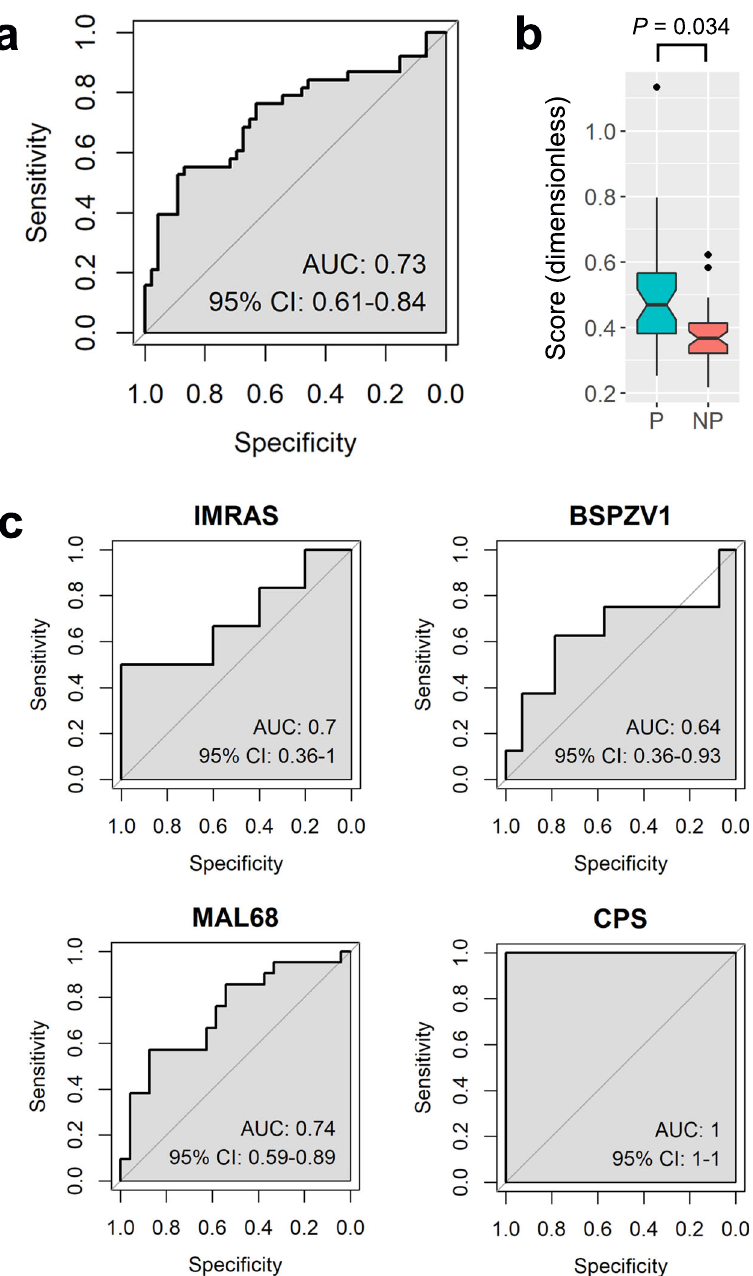
Fig. 5 Discriminatory power of the best-performing preimmunization score for classifying protected and non-protected trial subjects. a Receiver operating characteristic (ROC) curve showing performance of the score across 84 subjects pooled across trials. b Boxplots showing score distributions among subjects who were protected (P) following malaria challenge and those who were not (NP). The lower and upper bounds of colored boxplot regions span the interquartile range (IQR), indicating the 25 th and 75 th percentiles of the distribution, respectively. Horizontal line within the colored region indicates the median; notches extend 1.58 * IQR / √ n around the median. Upper whisker extends to largest data value within 1.5 * IQR above the 75th percentile; lower whisker extends to smallest value within 1.5 * IQR below 25 th percentile. Black dots indicate outlying points. c ROC curves showing the performance of the score within each individual trial. (AUC area under the curve, CI con fi dence